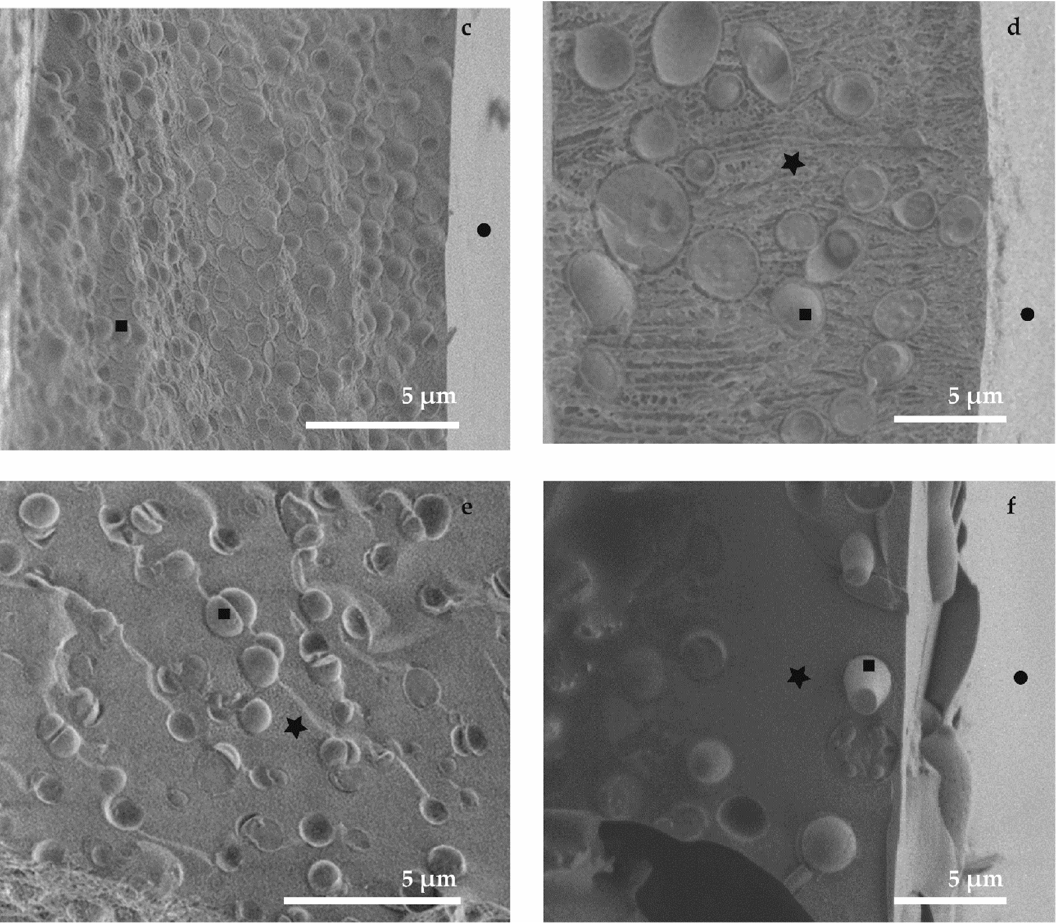
Figure 3. SEM micrographs showing the comparison of preparation protocols applied to microbial biofilms (in the left column S. epidermidis and in the right column C. parapsilosis ): ( a , b ) plunge freezing into nitrogen slush; ( c , d ) plunge freezing into liquid ethane; ( e , f ) freezing by HPF. Marks: stars—fully hydrated ECM, squares—microbes, dots—surface of biofilm layer; measurement parameters 1 to 2 keV and 6–8 mm.